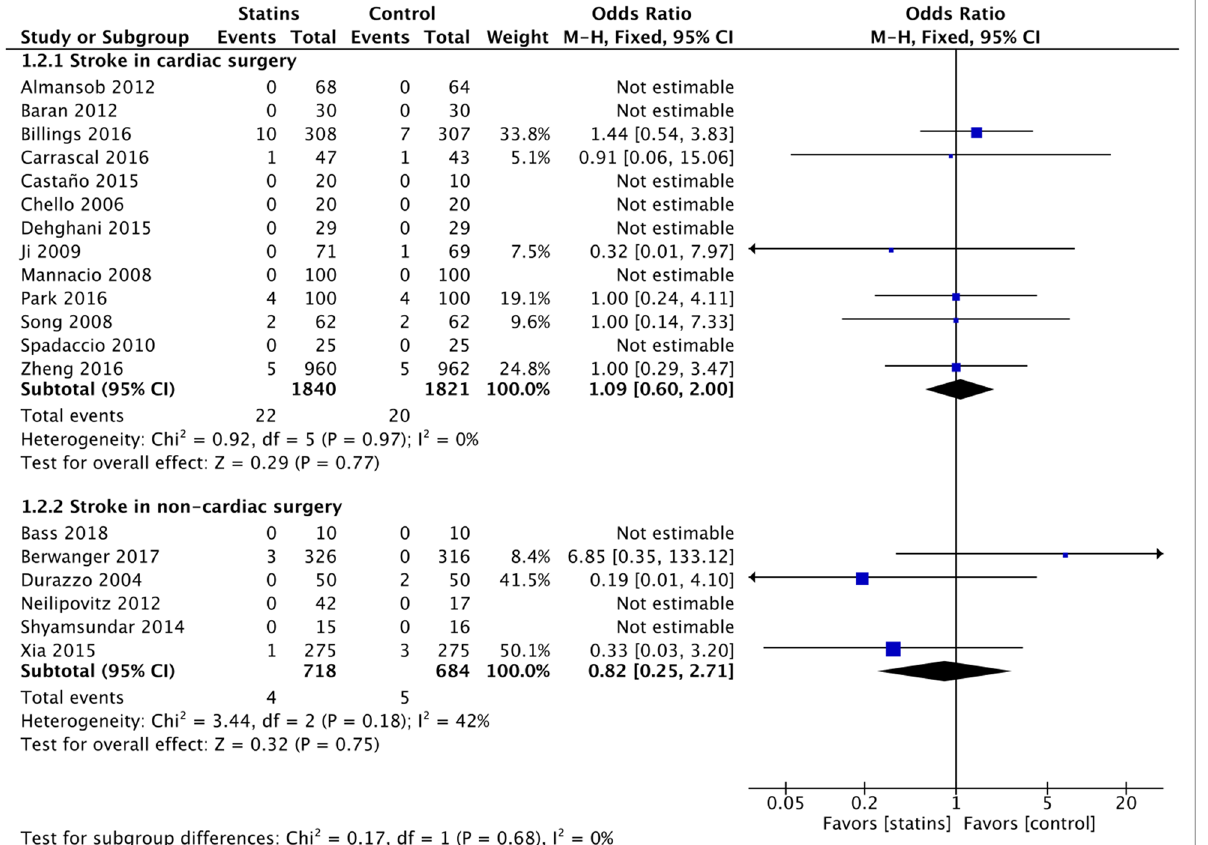
Fig. 4 Postoperative stroke. Forest plot for postoperative stroke in patients with perioperative statin therapy versus